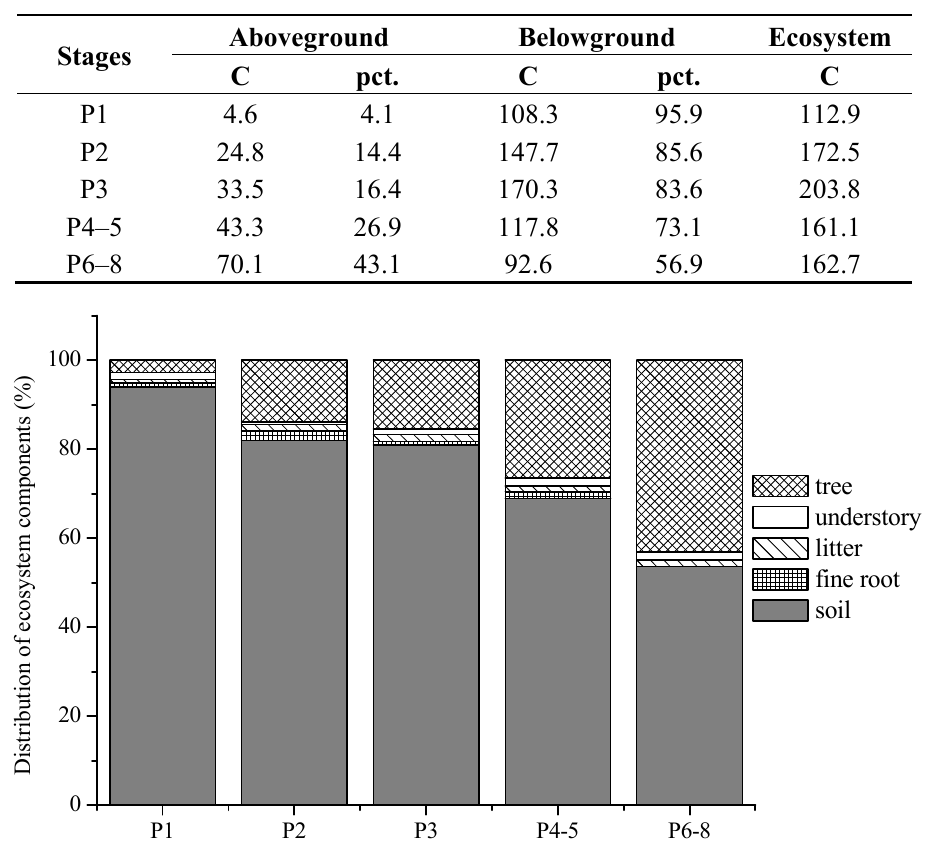
Figure 4. Percentage contribution to the C pool in the individual components of the Eucalyptus plantation